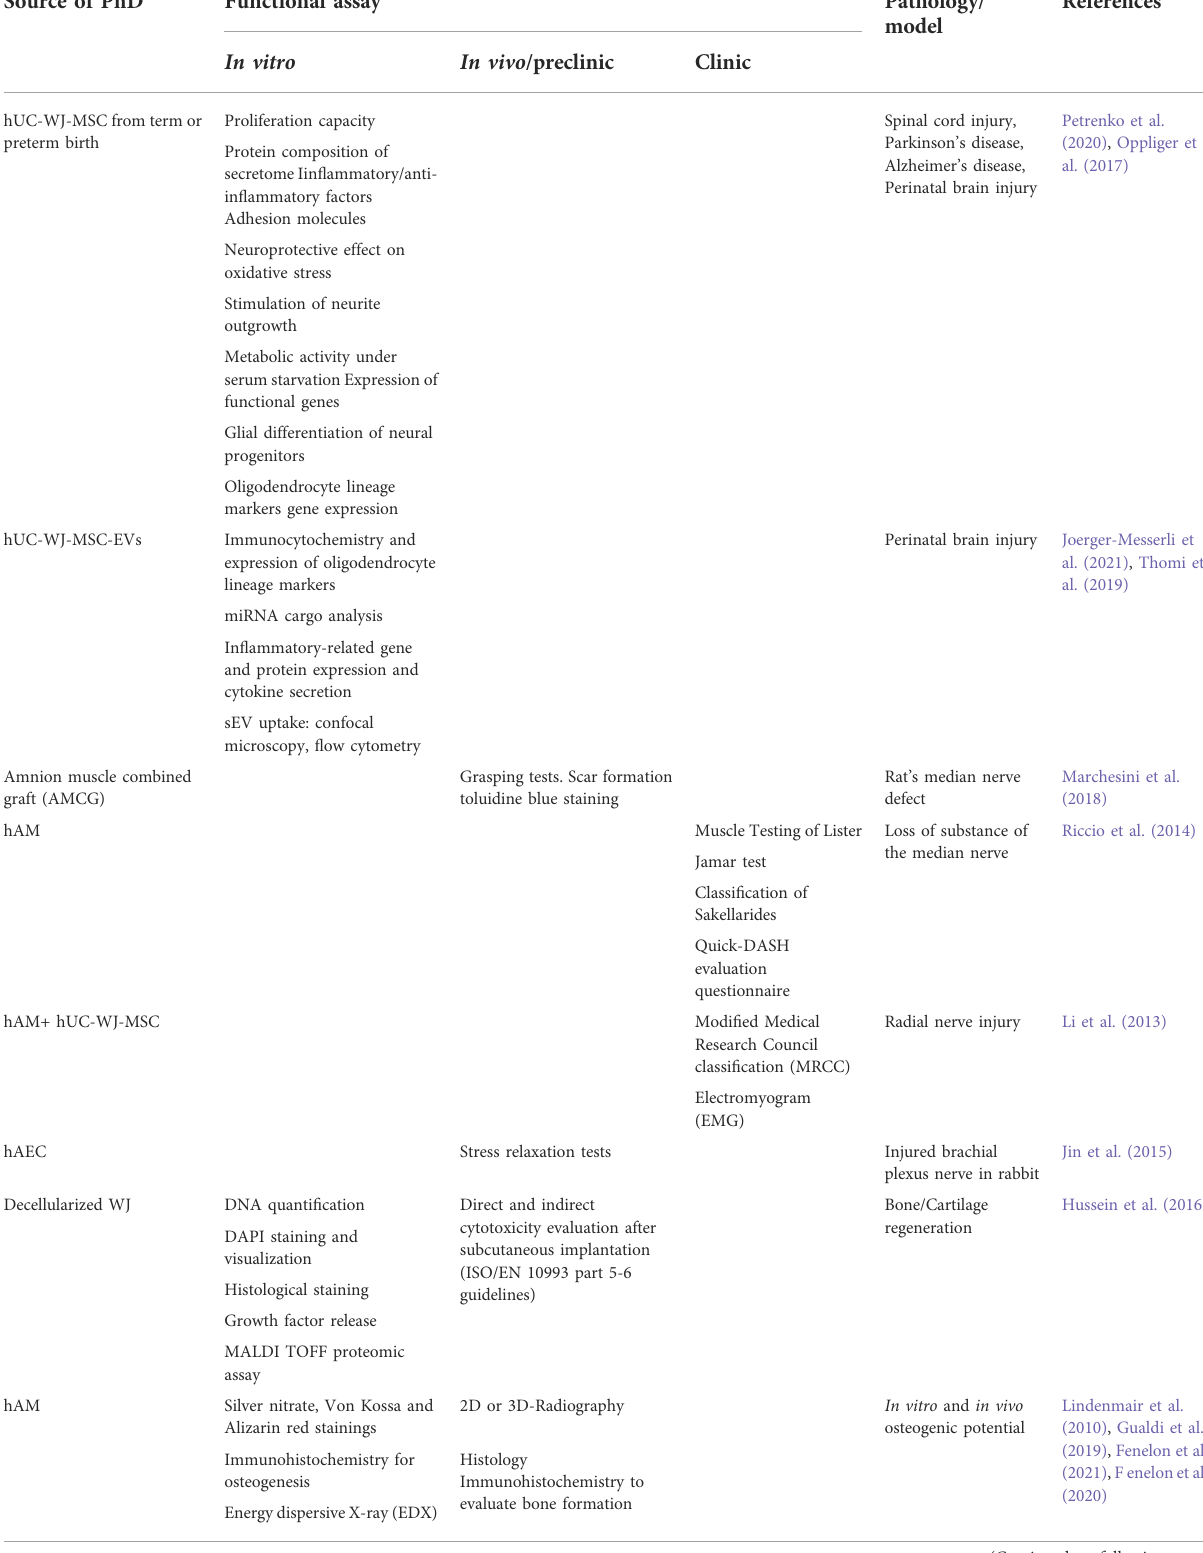
TABLE 1 Overview of the functional assays for the different compartments analyzed in the present